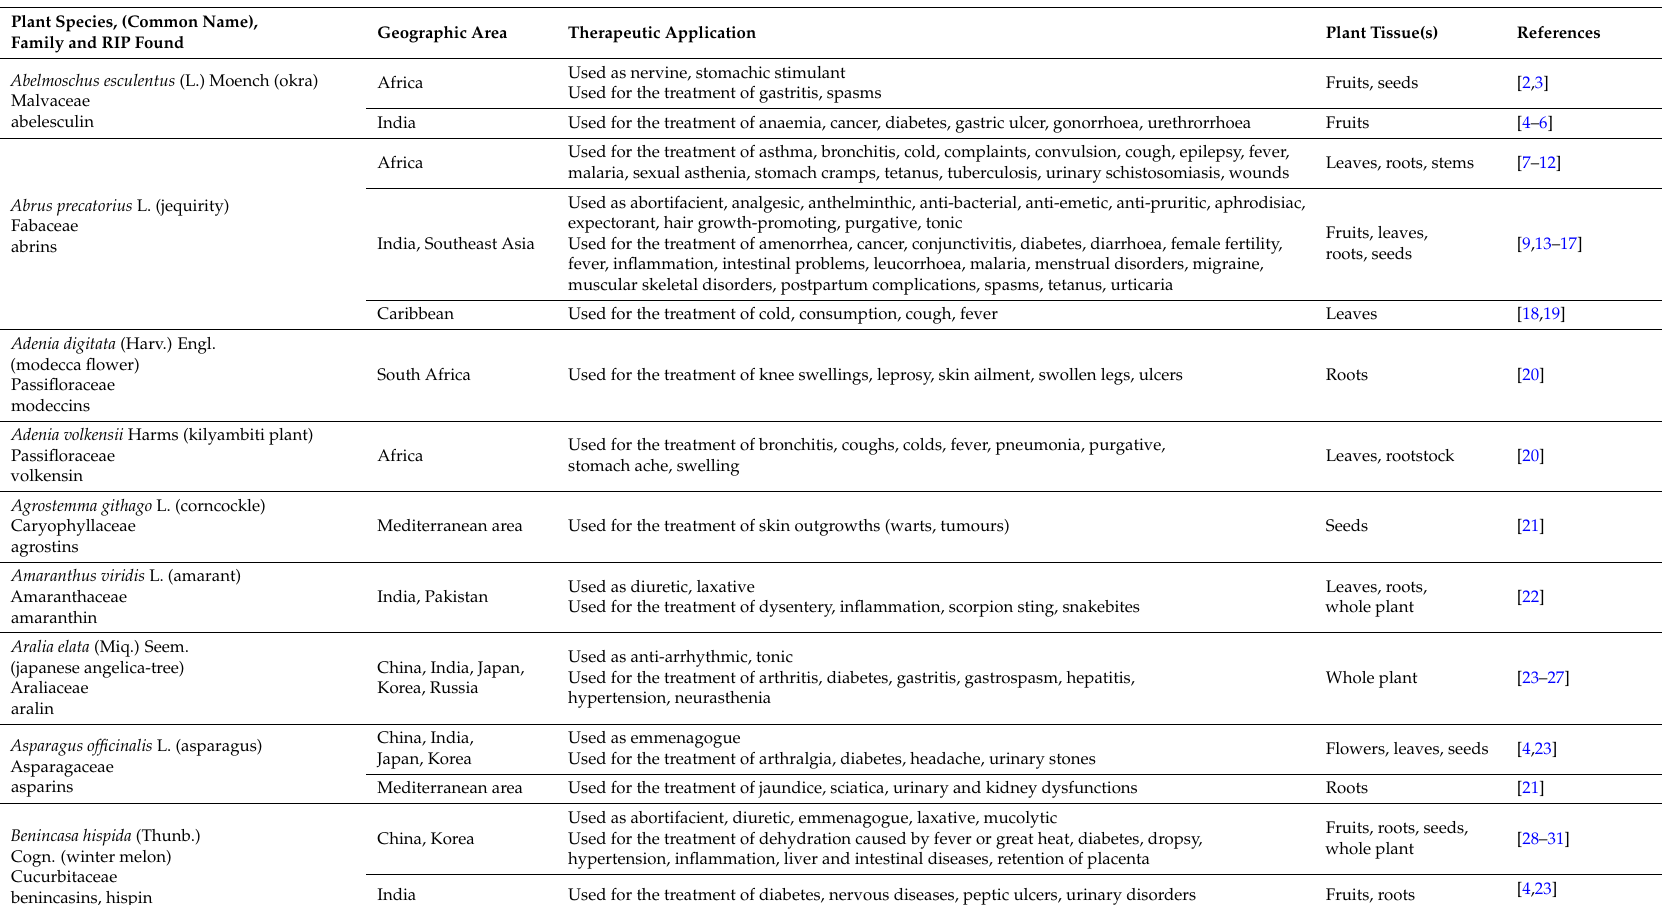
Table 1. Ethno-pharmacological uses of RIP-expressing